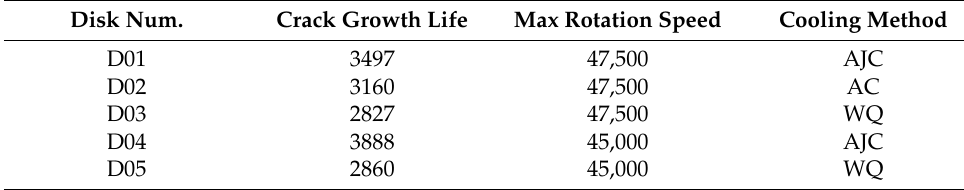
Table 5. Results of disc crack propagation